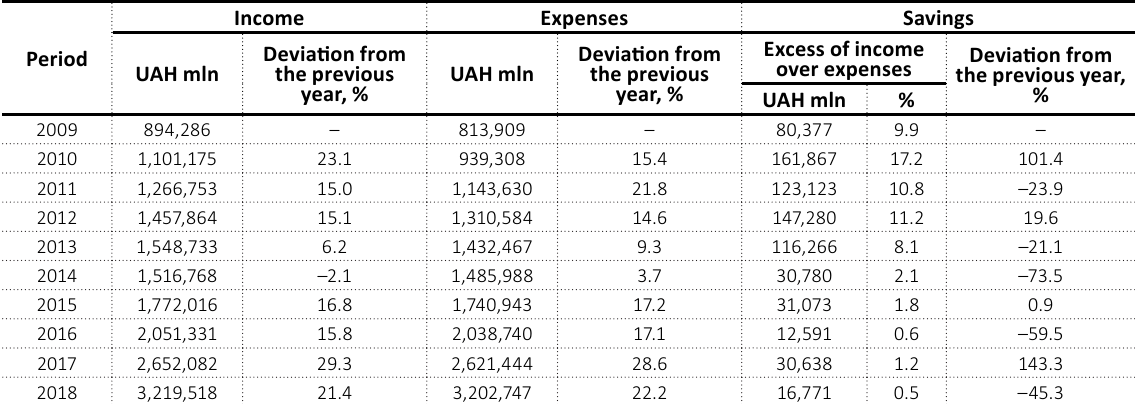
Table 1. Income and expenses of the population of Ukraine, UAH